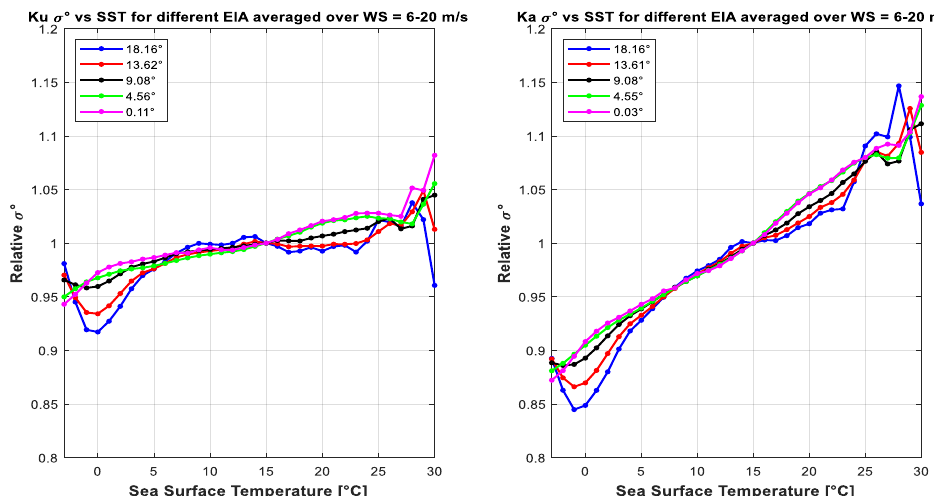
Figure 20. Relative sea surface temperature (SST) dependence of KuPR ( left ) and KaPR ( right ) σ 0 at different EIAs over averaged WS.